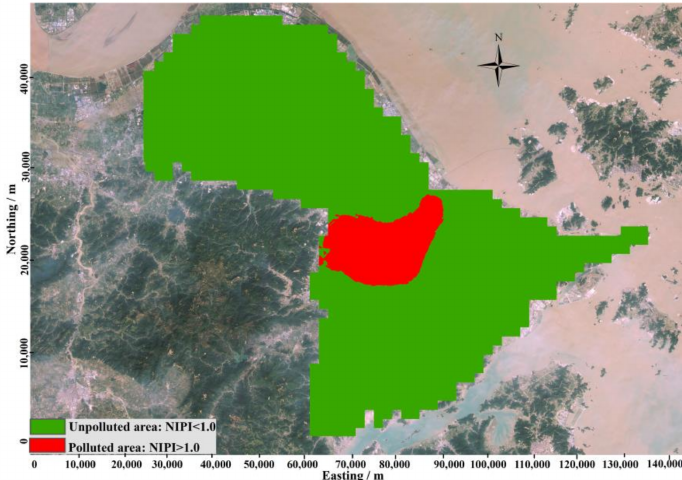
Figure 4. Delineation of composite heavy metal pollution according to the spatial distribution of Nemerow integrated pollution index